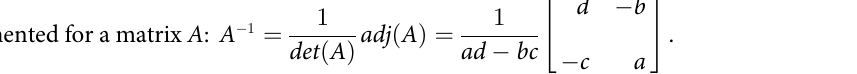
Bits reserved for the sign, exponent, and mantissa for half, single, double, extra, and quadruple precision. The largest and smallest positive numbers that can be represented are also shown for